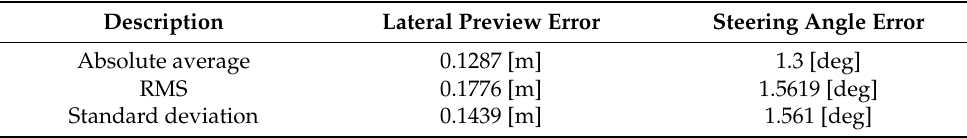
Table 5. SMC-based ellipse path tracking